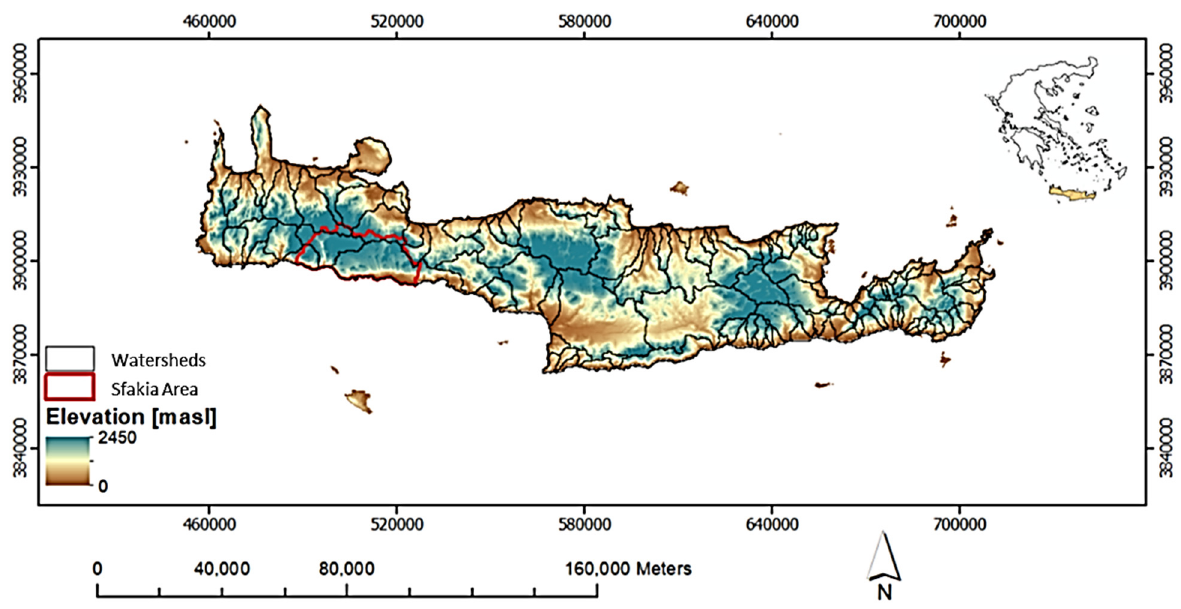
Figure 2. Location of Sfakia area and the elevation across the island of Crete.